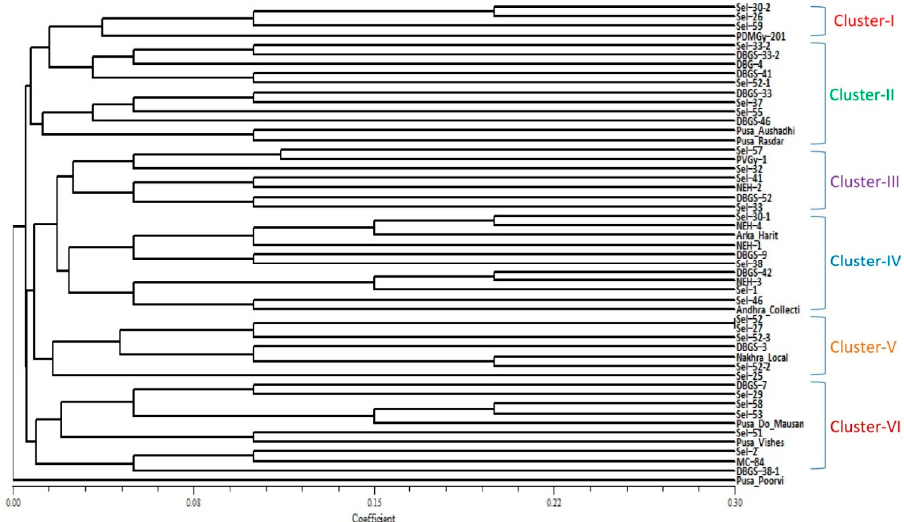
Figure 1. Morphological relationships among 51 accessions of bitter gourd, based on 10 quantitative characteristics by UPGMA clustering, based on Jaccard’s similarity coefficient.